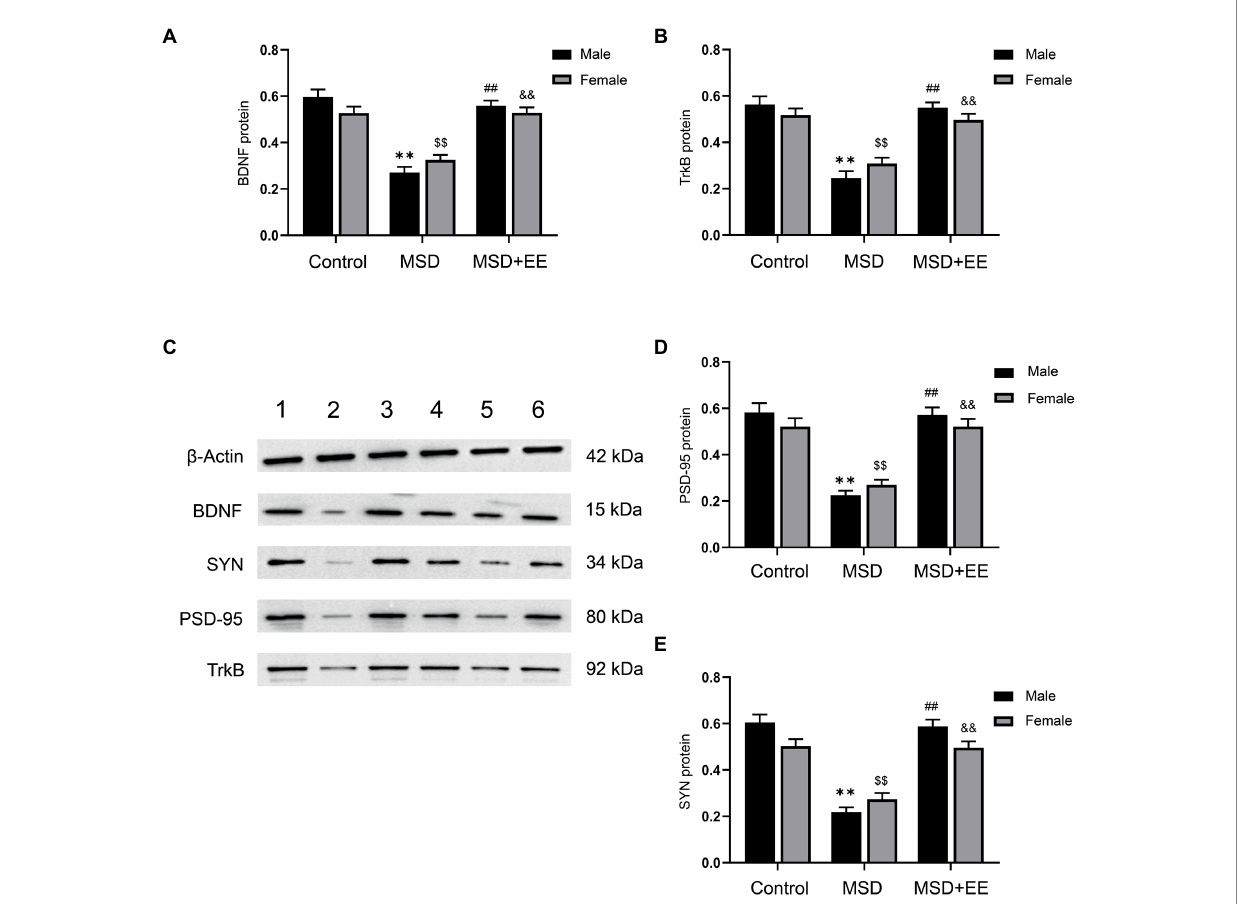
FIGURE 5 Effects of an environmental enrichment (EE) on synaptic plasticity-associated proteins in the hippocampus of elderly offspring mice exposed to maternal sleep deprivation (MSD). (A) Expression level of BDNF in the hippocampus. (B) Expression level of TrkB in the hippocampus. (C) Representative western blotting of BDNF, TrkB, PSD-95, and SYN proteins in the hippocampus: band 1, Control group-male; band 2, MSD-group male; band 3, MSD + EE group-male; band 4, Control group-female; band 5, MSD group-female; band 6, MSD + EE group-female. (D) Expression level of PSD-95 in the hippocampus. (E) Expression level of SYN in the hippocampus. ** p < 0.01 vs. Control group in males; $$ p < 0.01 vs. Control group in females; ## p < 0.01 vs. MSD group in males; && p < 0.01 vs. MSD group in